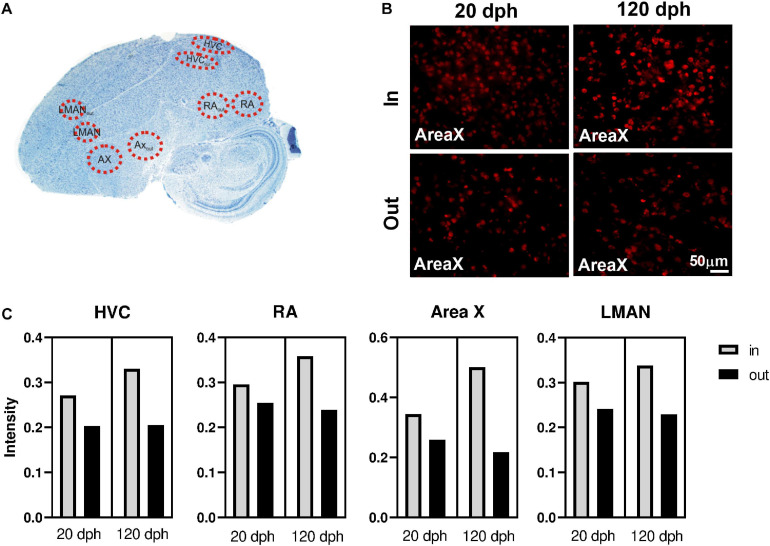
Immunofluorescence of 5-methylcytosine (5mC) in zebra finch telencephalon at 20 and 120 dph. (A) Overview of the analyzed regions on a Nissl-stained sagittal section of a 120-dph zebra finch brain. (B) 40× photomicrographs of Area X and its surrounding region (Area Xout) in brain sections of a 20- and a 120-dph old zebra finch, as an example of the 5mC-specific antibody staining used for intensity measurements. (C) Average 5mC intensity per cell nucleus in HVC, RA, Area X, and LMAN at 20 and 120 dph. Raw means were calculated as the mean intensity of the cells within the region considered, averaged over the four birds for that time point.